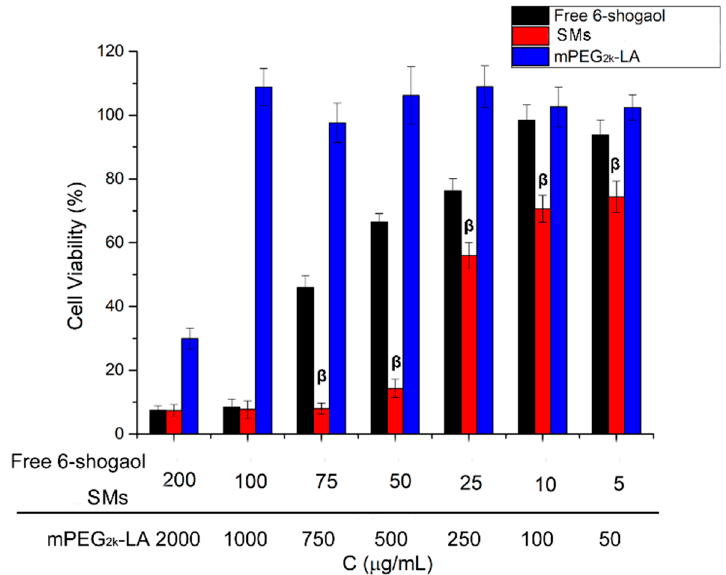
Figure 3. Cell viability of different samples (mPEG 2k -LA, free 6-shogaol and SMs) with varied concentrations for 72 h using a 3-(4,5-dimethyl-2-thiazolyl)-2,5-diphenyl-2-H-tetrazolium bromide (MTT) bioassay against HepG2 cells. β P < 0.01 SMs versus free 6 ‐ shogaol.